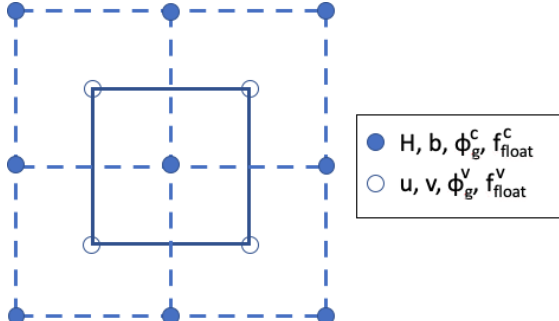
Figure 1. Schematic of the CISM grid with ice thickness H and bed topography b located at cell centers (filled circles) and velocity components (u,v) at cell vertices (unfilled circles). The grounded ice fraction φ g and flotation function f float can be computed at ei- ther centers or vertices as denoted by superscripts c and v, respec-